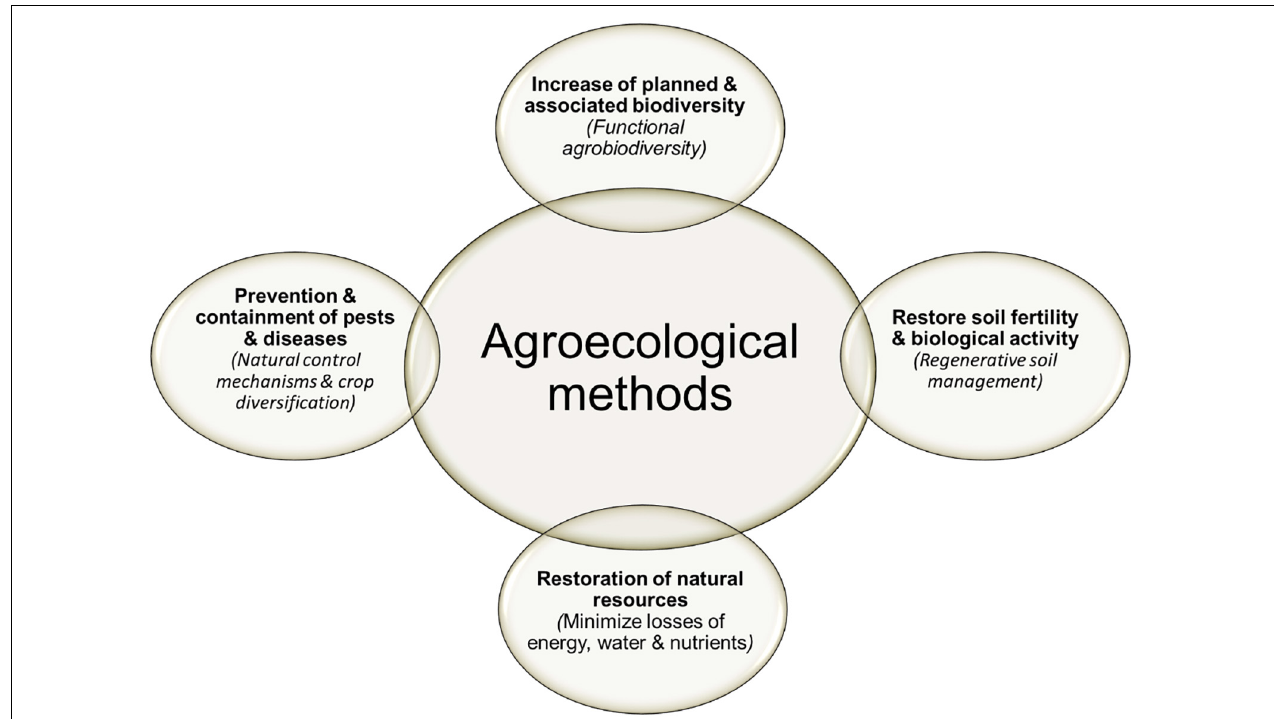
FIGURE 5 | Agroecological methods generating ecosystems services related to health of ecosystems, animals, and people.